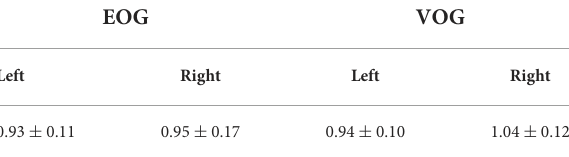
TABLE 1 Mean VOR gains for left and right impulses and their standard deviations for each oculography system ( n = 19). EOG VOG Left